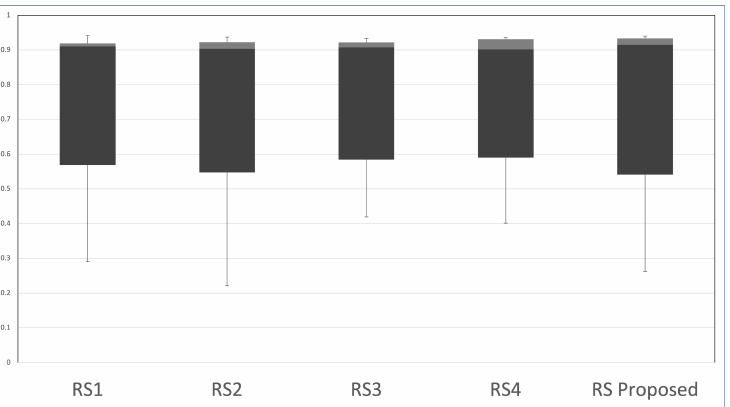
Figure 9. Performance comparison of different network configurations used in ablation study.